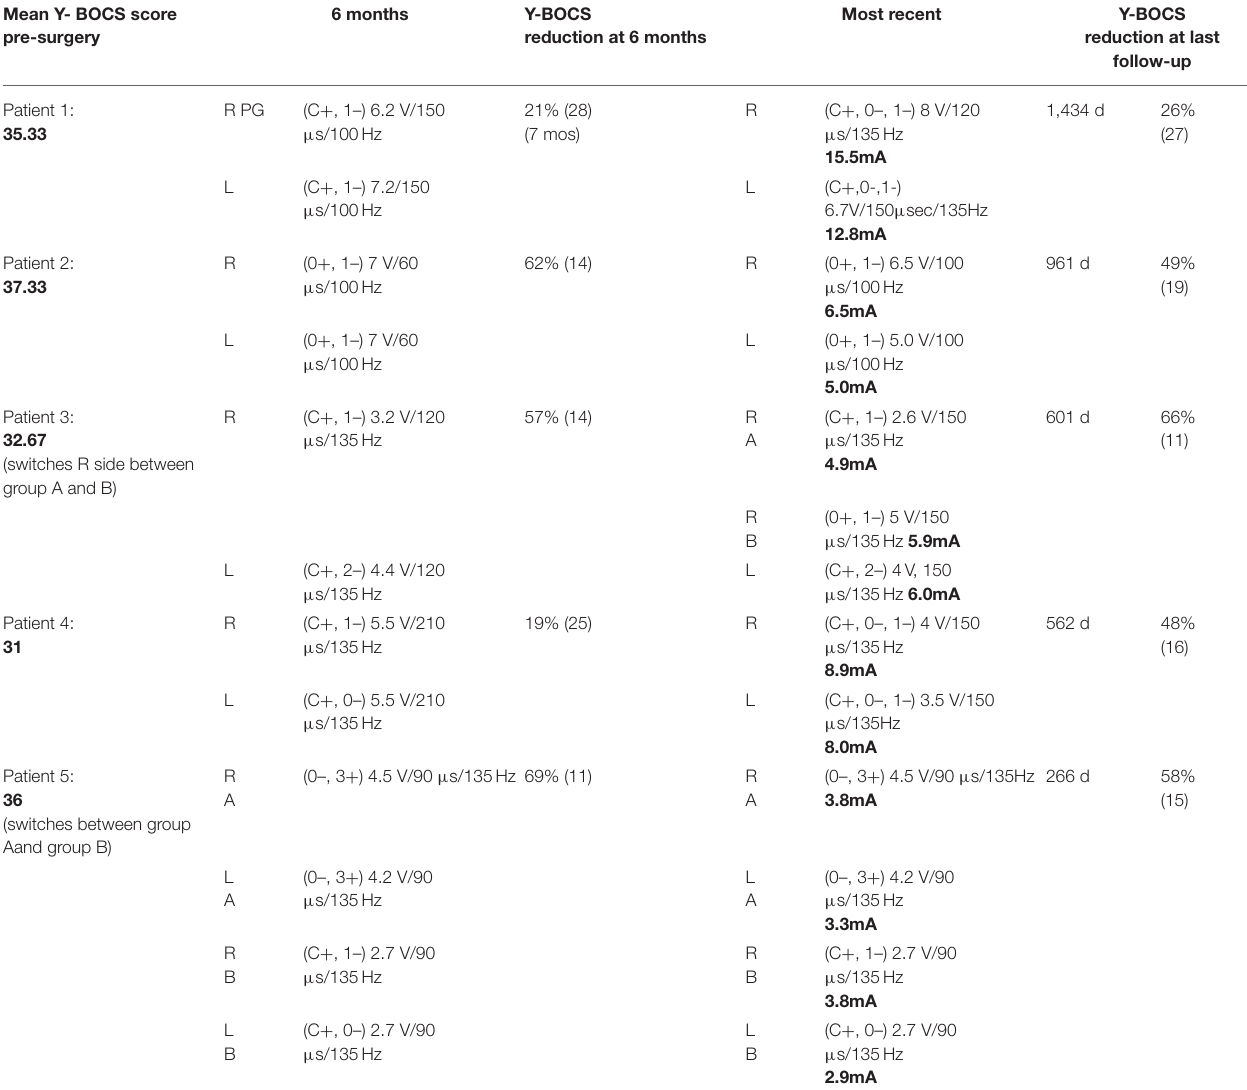
Most recent Y-BOCS